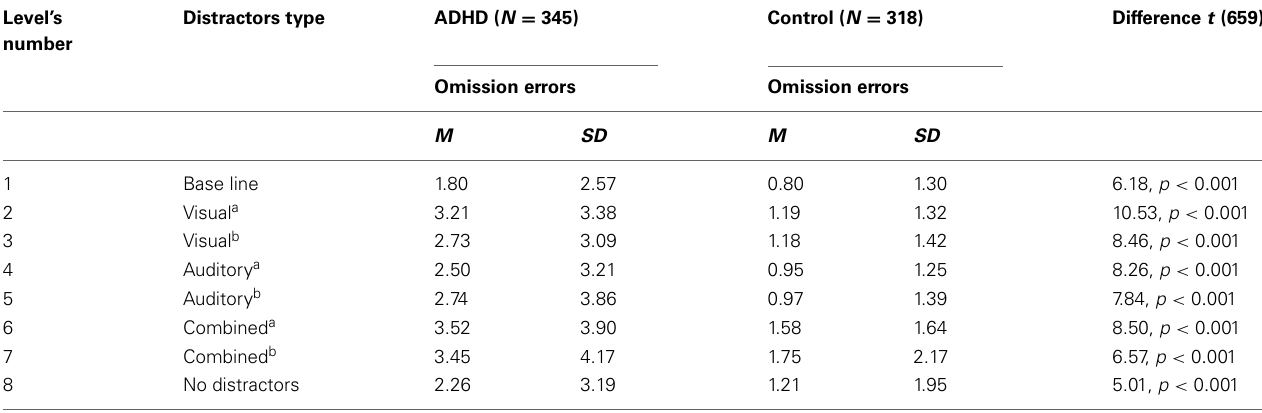
Table 1 | Differences in Omission errors between ADHD and non-ADHD Children.